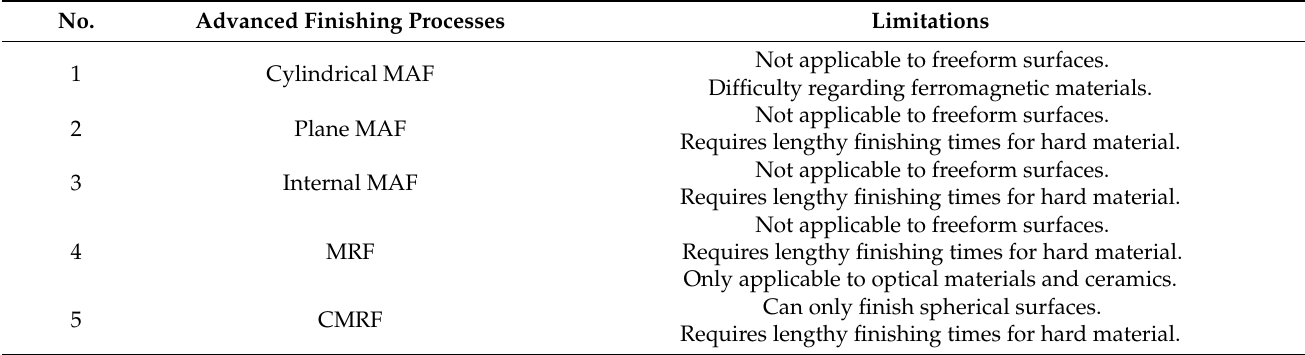
Table 3. Limitations of non-conventional finishing processes [49,64,107,108].